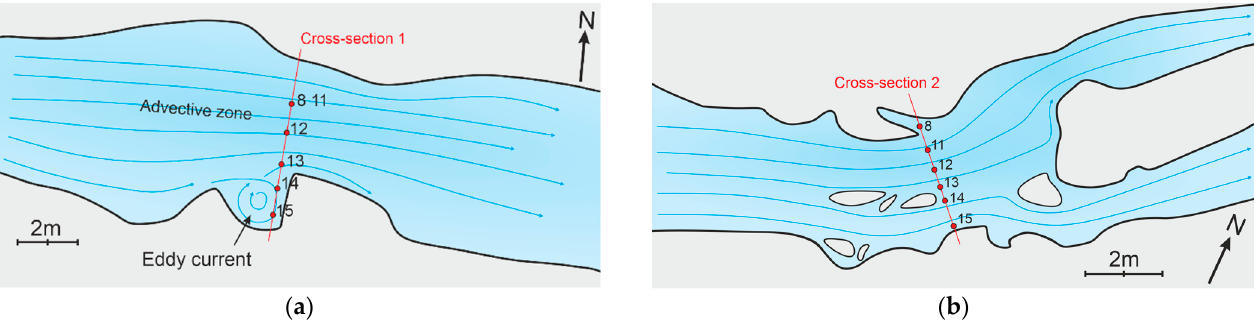
Figure 10. Synthetic representation of streamlines and fluorometer locations for cross-sections 1 ( a ) and 2 ( b ).